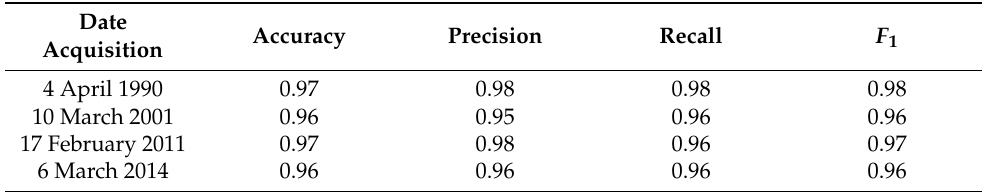
Table 5. Accuracy assessment of the classified map using Landsat images in 1990, 2001, 2011, and 2014.